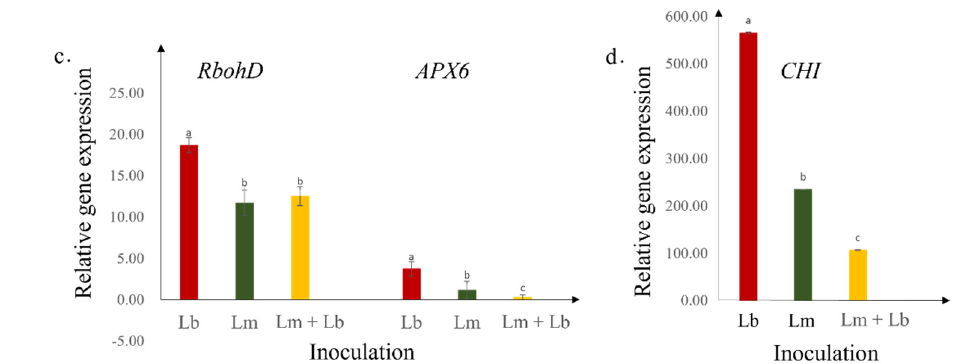
Figure 4. Relative transcript levels of several important genes involved in host defense signaling pathways were assessed by quantitative RT-PCR at 7 days post-inoculation. The expression of WRKY70 and PDF1.2 showed significantly higher expressions in Lm solely inoculated cotyledons. PR1 , WRKY33 , RbohD , APX6 , and CHI showed significantly higher expression in cotyledons inocu- lated with only Lb. ( a ) Relative gene expression of WRKY70 and PR1 ; ( b ) Relative gene expression of WRKY33 and PDF1.2 ; ( c ) Relative gene expression of RbohD and APX6 ; ( d ) Relative gene expression of CHI ; in Westar cotyledons inoculated with only DsRed-tagged L. biglobosa (Lb), with only GFP-tagged L. maculans (Lm) and co-inoculated with both isolates (Lm + Lb). Different letters refer to significant differences ( p ≤ 0.05).